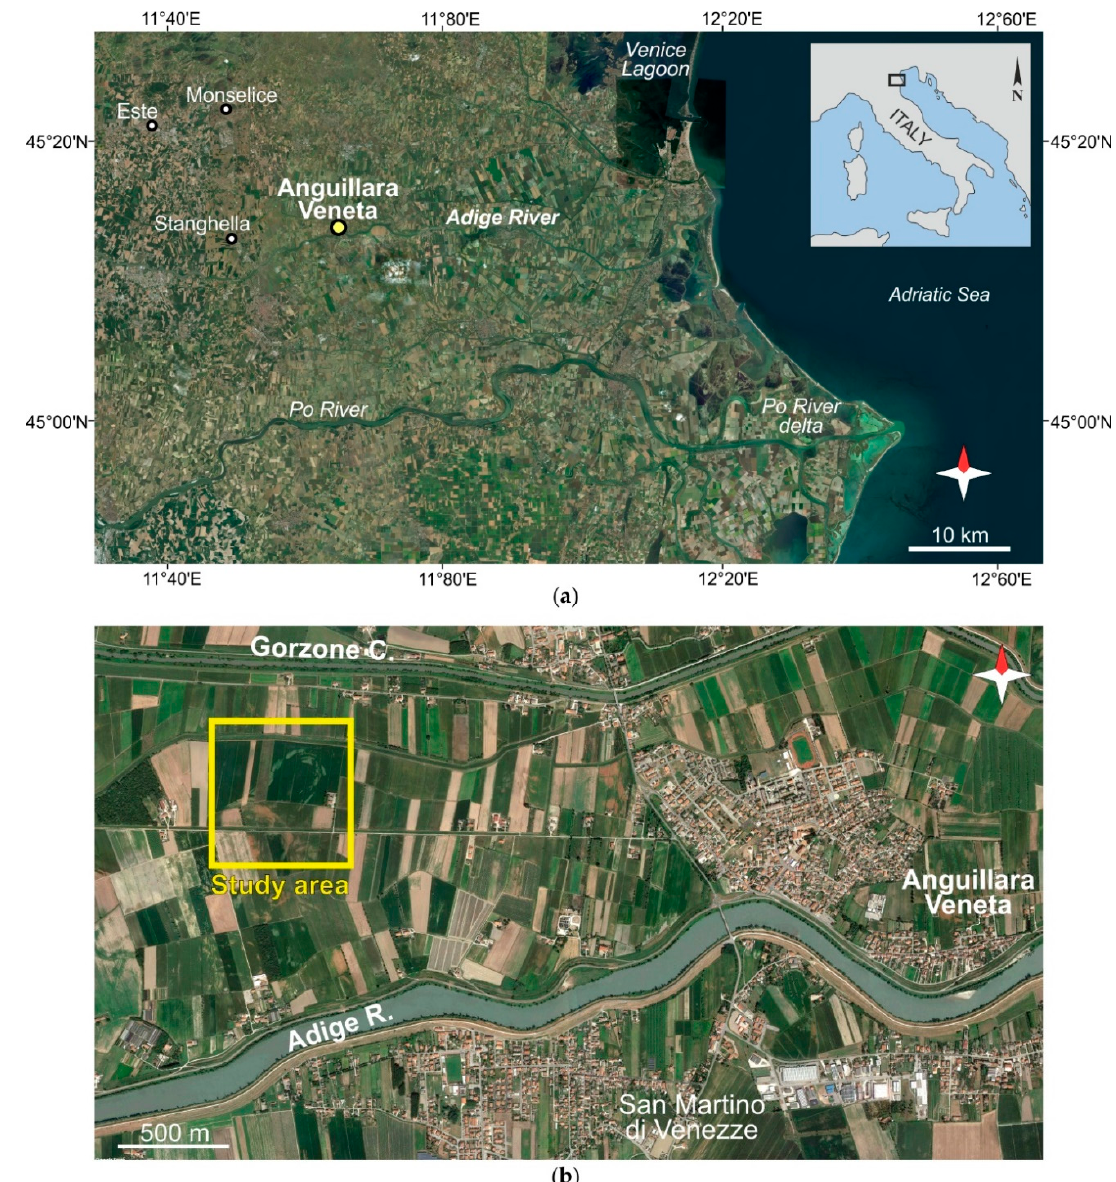
Figure 1. The study site: ( a ) location of Anguillara Veneta town in the southern Venetian Plain, at the boundary with the Po Plain sensu strictu; ( b ) satellite image (2013) of the study area (yellow box) in Anguillara Veneta town, PD (Italy).